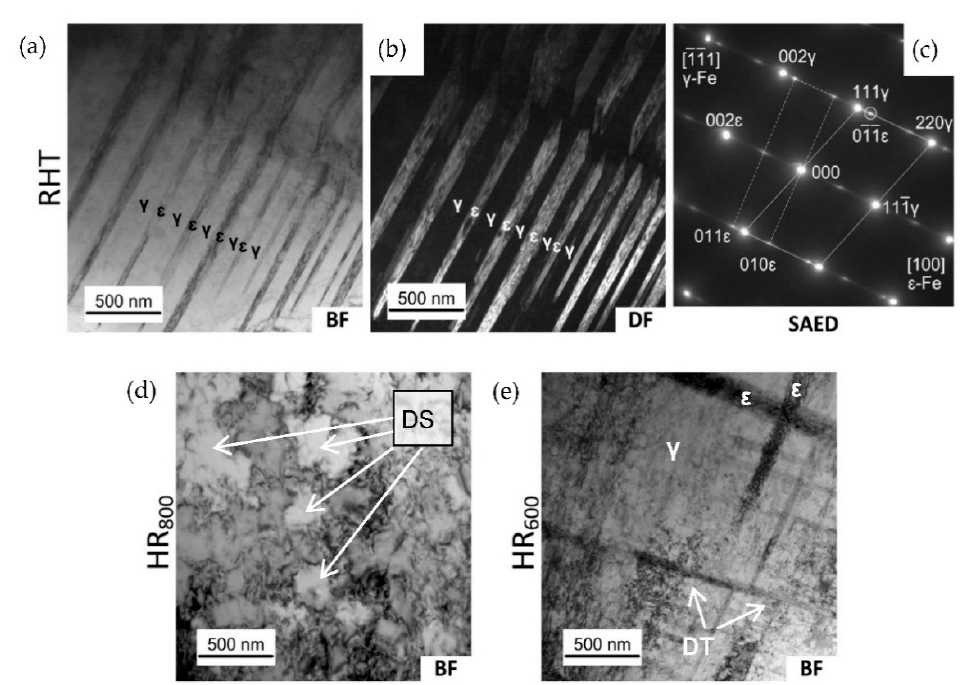
Figure 2. Structure of the Fe-30Mn-5Si alloy: ( a – c ) RHT; ( d ) HR 800 ; ( e ) HR 600 . Transmission electron microscopy. Bright field (BF) and dark field (DF) images, and SAED pattern. DF is taken from 011 reflex circled in ( c ). DS—dislocation cells; DT—dislocation tangles.